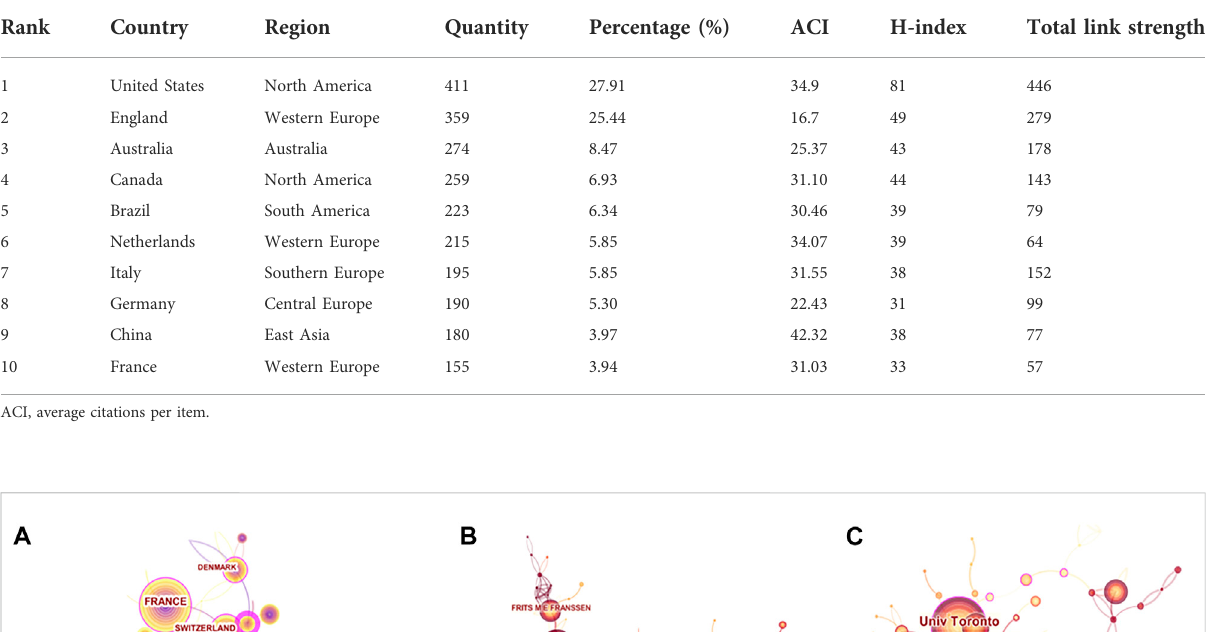
TABLE 1 Top 10 productive countries.